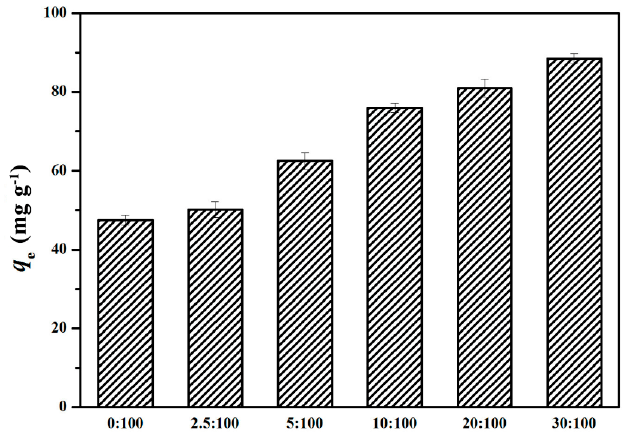
Figure 6. Effects of GO to cellulose ratios on Cu 2+ ion adsorption on the hydrogel. The error bars represent standard deviations based on three measurements.